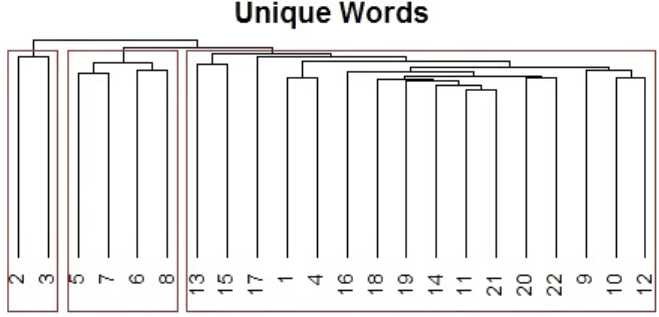
Fig. 9. Ascending hierarchical clustering using